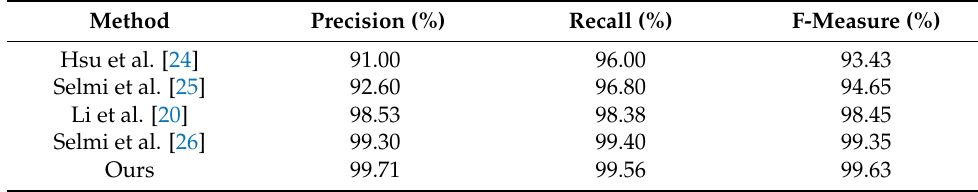
Table 3. Detection results on AOLP-AC.